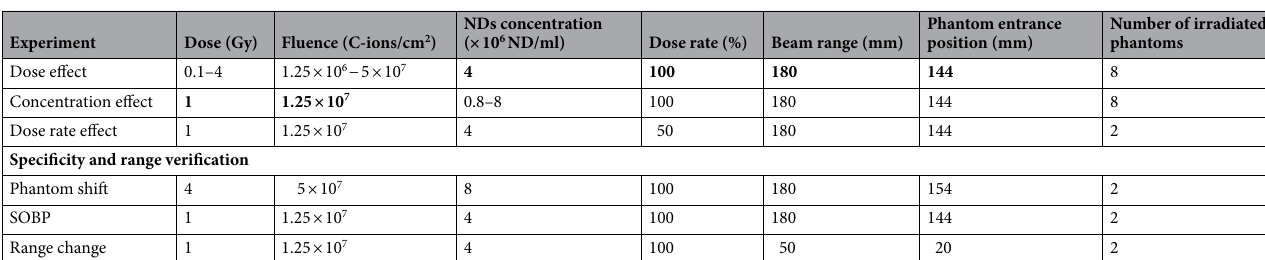
Table 1. Experimental parameters for the evaluation of C-ions triggered PVA/PFB NDs vaporization at 37 °C and 312/u MeV beam energy. The values highlighted in bold are considered to be the reference parameters for the different